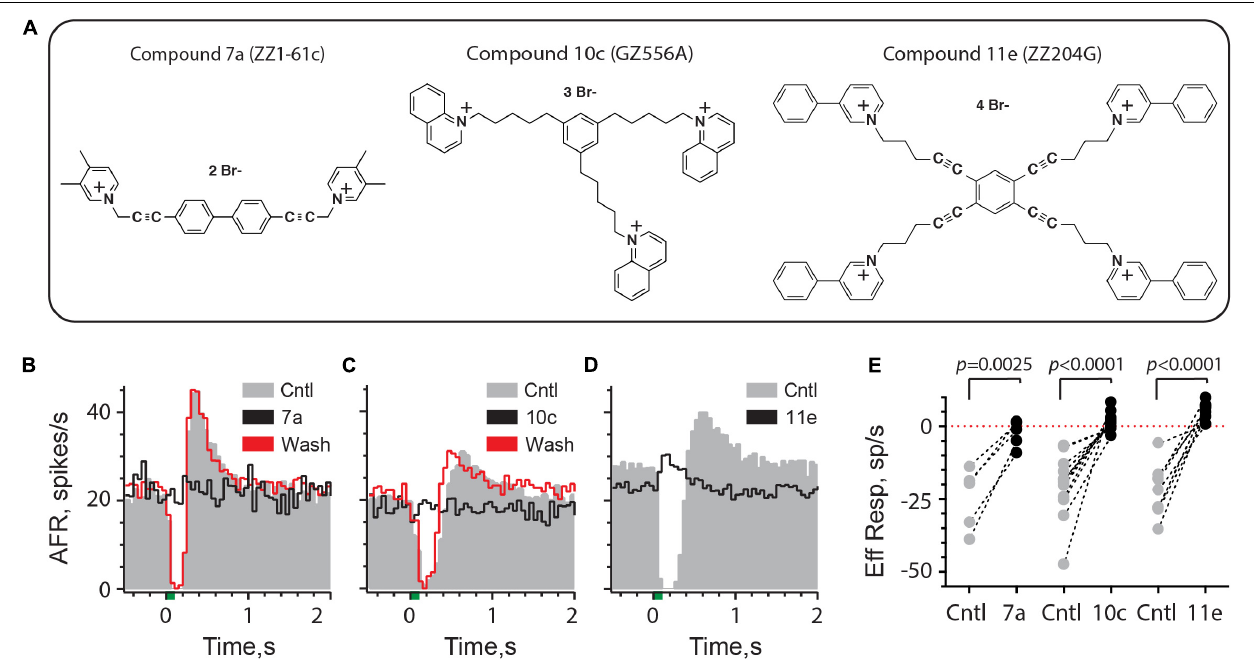
FIGURE 5 | Efferent-mediated inhibition of turtle vestibular afferents is antagonized by charged α 9 α 10nAChR blockers. (A) Chemical structures of bis, tris, and tetrakis quaternary ammonium compounds 7a, 10c, and 11e are shown (see also Zheng et al., 2011). (B–D) Average response histograms showing the effects of efferent stimulation in turtle bouton afferents before (Cntl, gray) and during the application of Compound 7a, 10c, or 11e (Black trace), respectively. Efferent-mediated inhibition was recovered after washout (Wash, red trace) with Compounds 7a and 10c. Efferent shock trains (20 shocks at 200/s, green bar at t = 0) were repeated every 3 s and all histograms were based on at least 20 shock train presentations. (E) Mean afferent responses to efferent stimulation (Eff Resp) are plotted for multiple afferents before (Cntl, gray-filled circles) and after the application of Compound 7a, 10c, or 11e (black-filled circles). Negative values indicate inhibition while positive values reveal efferent-mediated excitatory effects. Indicated p -values from comparisons made using a paired t -test. Binning in (B–D) is 50